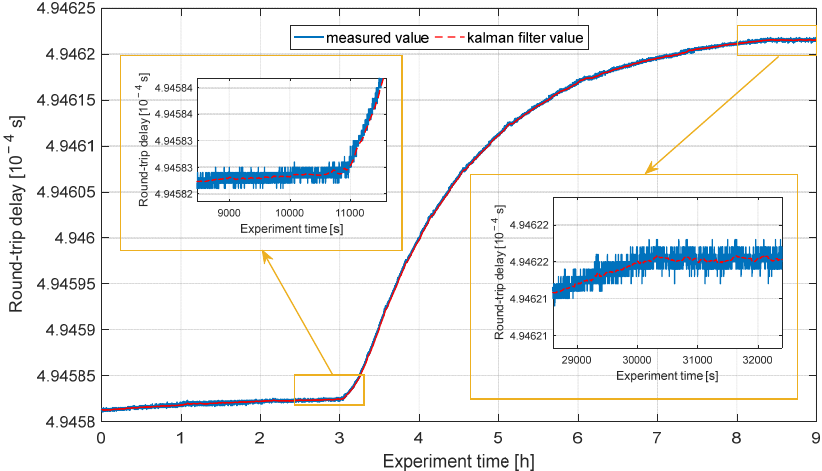
Figure 5. Round-trip delay after Kalman filtering.